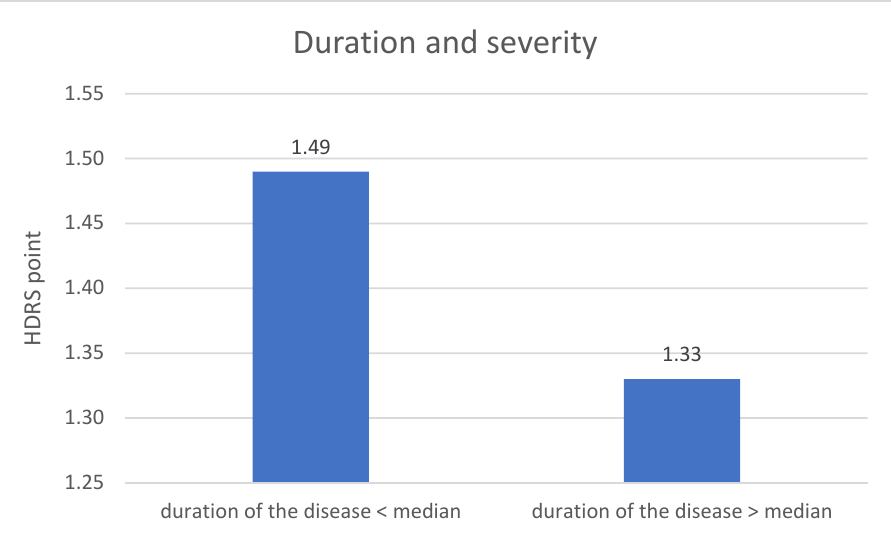
Figure 5. Duration of the disease and the severity of depression—1 measurement. Paired difference tests between the measurements were also performed. The following relationships were